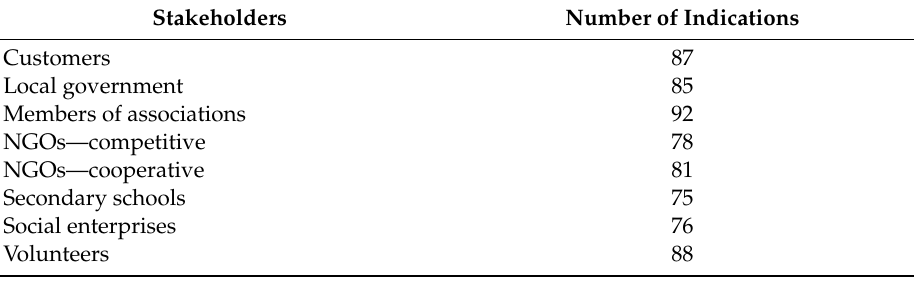
Table 1. Key stakeholders indicated by social economy organizations (SEOs) ( n =